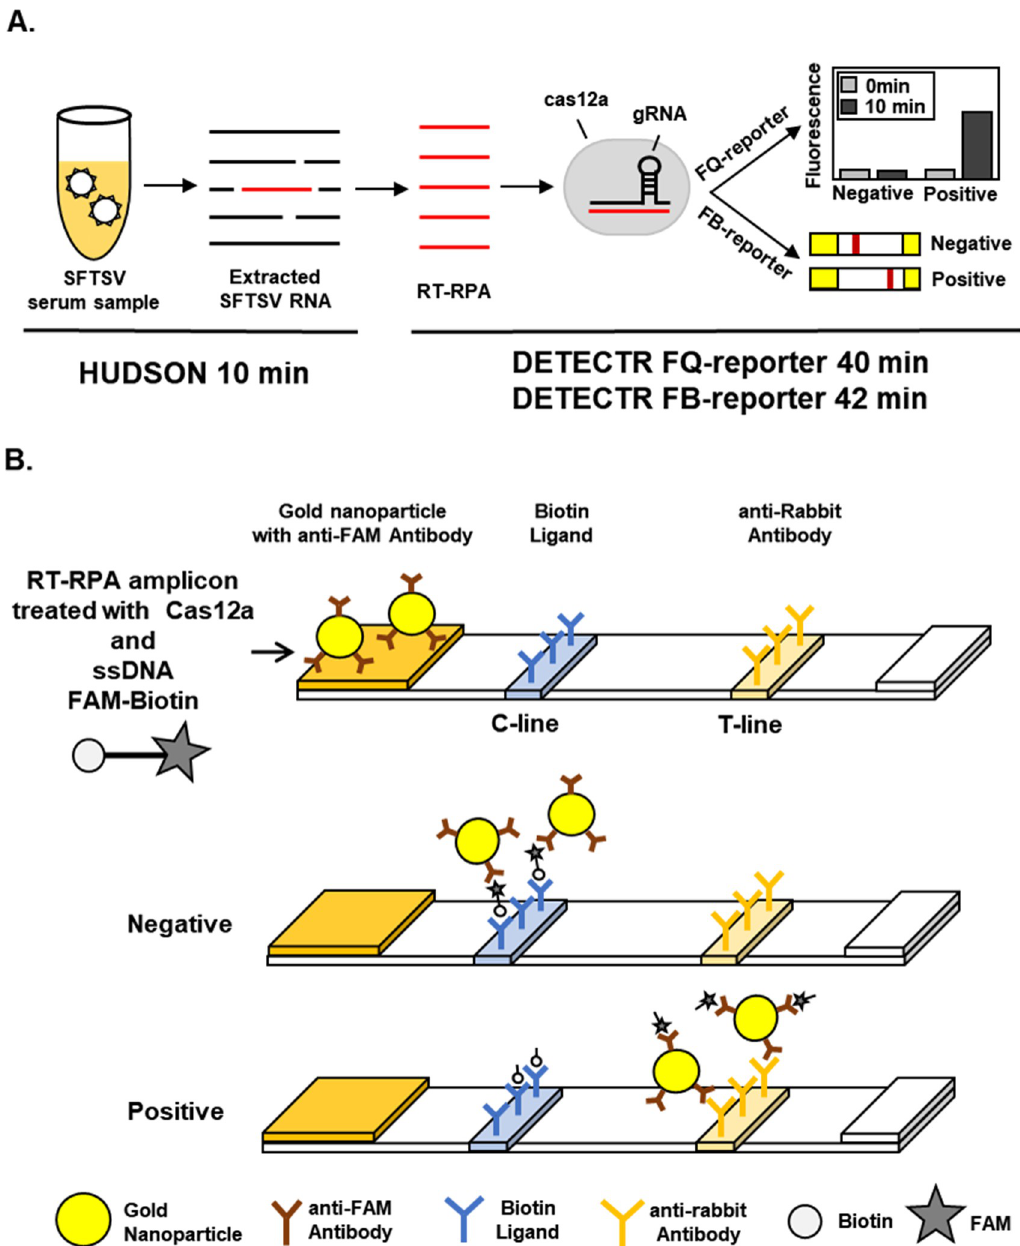
of the FB-reporter by Cas12a. FQ-reporter, fluorescence-quencher reporter; FB-reporter, FAM-Biotin lateral flow strip reporter; C-line, control line; T-line, test